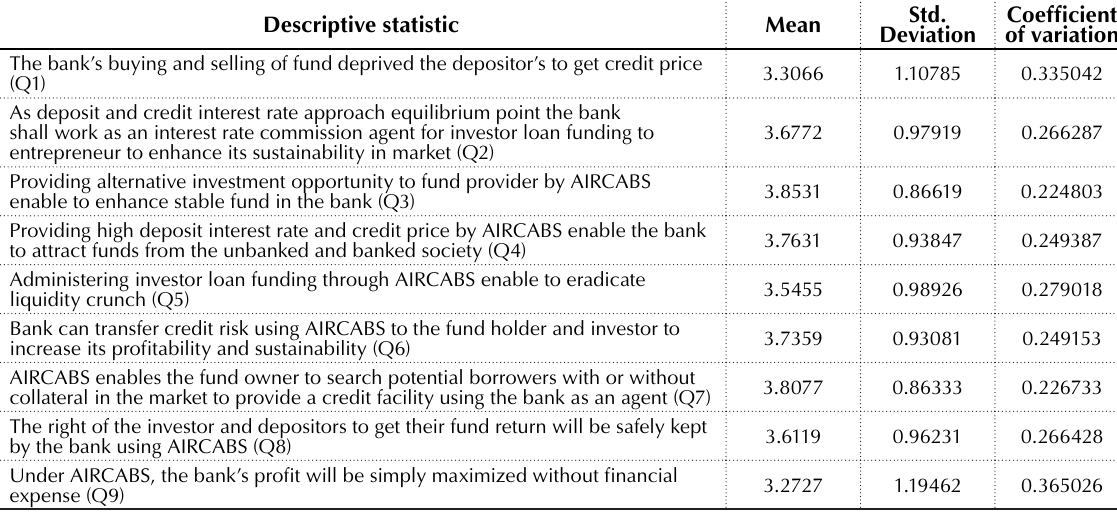
Table 11. Descriptive statistics for